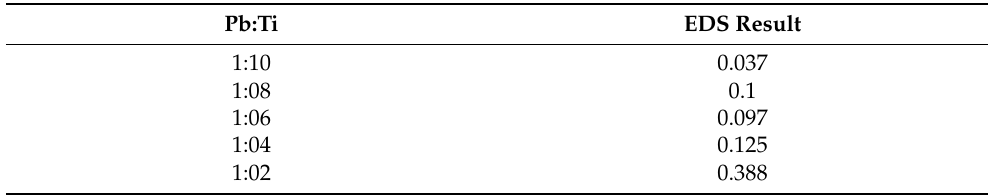
Figure 3. UV-vis absorbance spectrum of the CH 3 NH 3 PbI 3 /TiO 2 composite thin films prepared from PbO-TiO 2 thin film with different ratios of Pb:Ti. Table 2. EDS analysis of the CH 3 NH 3 PbI 3 /TiO 2 composite thin films prepared from PbO-TiO 2 thin film with different ratios of Pb:Ti.